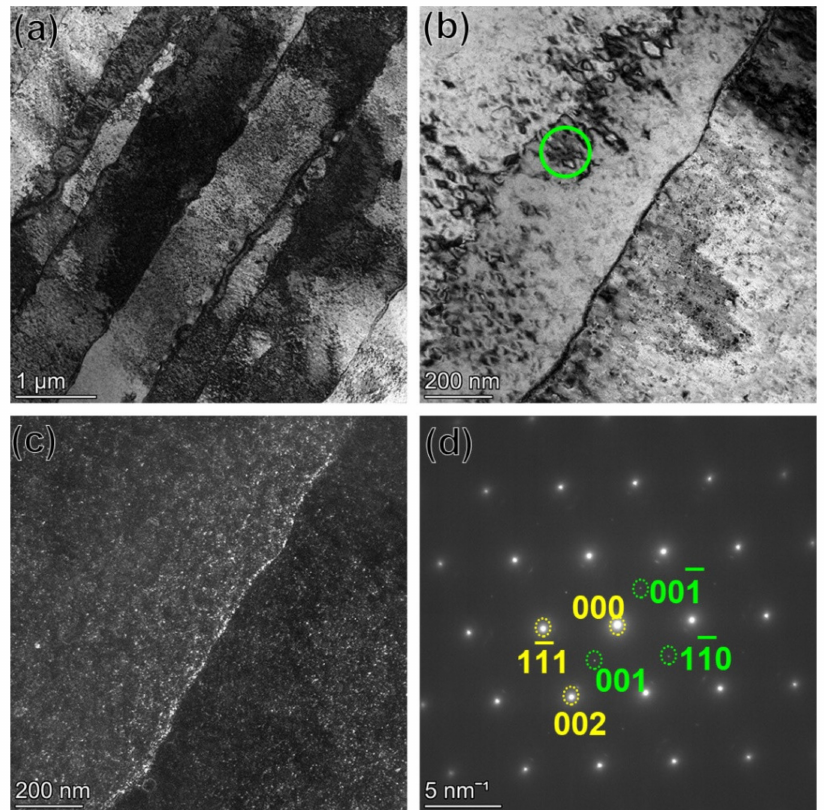
Figure 5. The microstructure of the SLM GTD222 after standard heat-treated. ( a ) Columnar structure, ( b ) enlarged columnar structure, ( c ) dark-field image of the columnar structure, ( d ) selected area electron diffraction of green circle area marked in ( b ), the γ ’ and γ were indexed using green and yellow font,